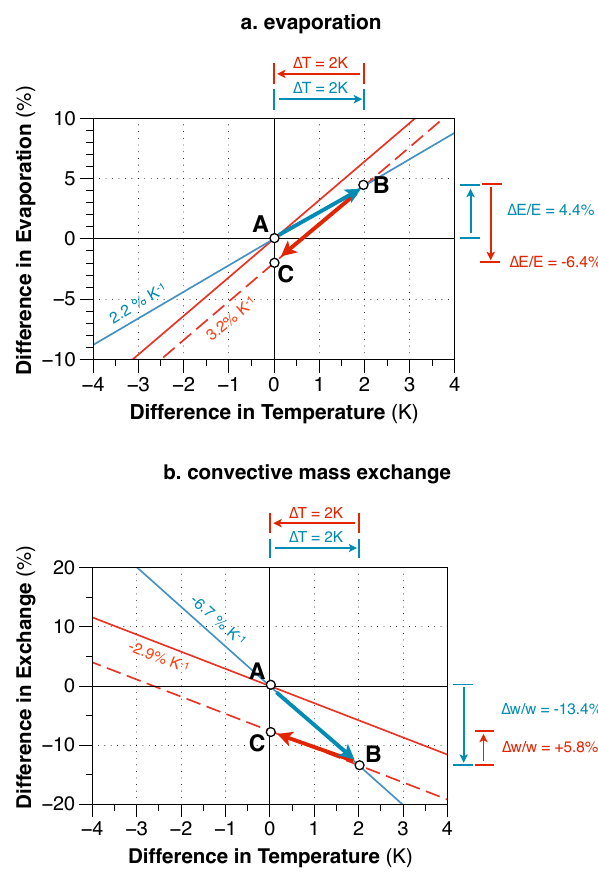
Fig. 4. Illustration of the contrary effects of greenhouse vs. solar- induced changes on (a) evaporation, E , and (b) convective mass exchange, w . The sensitivity of evaporation to a surface warm- ing of 1T s =2K by an elevated greenhouse effect results in an in- crease of 2.2%K − 1 , resulting in a change from point A to B (blue line). A geoengineering response aimed at compensating this in- crease in surface temperature by reducing solar radiation would change evaporation at a rate of 3.2%K − 1 , resulting in a change from point B to C (red line). Likewise, the surface warming would decrease the vertical exchange velocity, w , by − 6.7%K − 1 (point A to B), while the geoengineering response would increase it at a rate of 2.9%K − 1 (point B to C). Hence, while the geoengineering re- sponse may undo differences in surface temperature, it cannot com- pensate changes in the hydrologic cycle and vertical mass exchange at the same